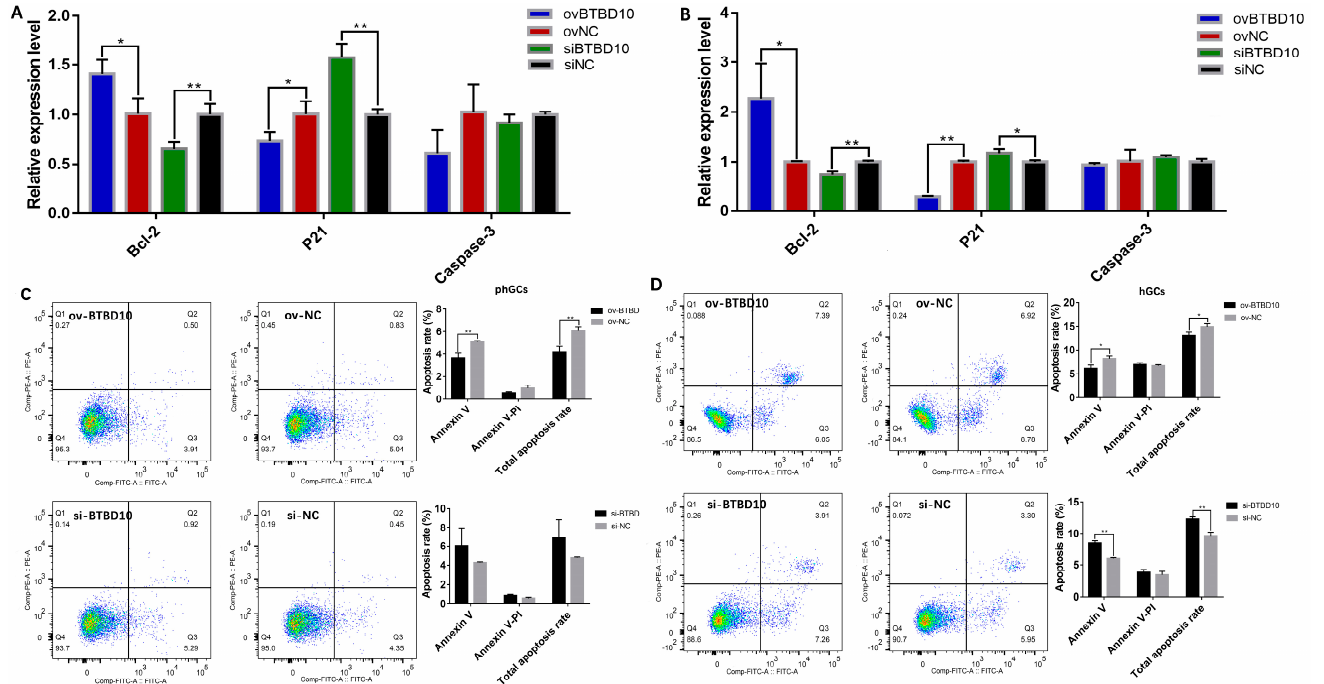
Figure 6. Effect of BTBD10 on apoptosis of phGCs and hGCs. The relative expression of the apoptosis-related gene in phGCs ( A ) and hGCs ( B ) after overexpression/interference of BTBD10 (n = 3). The apoptosis rate of phGCs ( C ) and hGCs ( D ) after overexpression/interference of BTBD10 (n = 3). Data are means ± SD of technical replicates. * p < 0.05, ** p < 0.01.